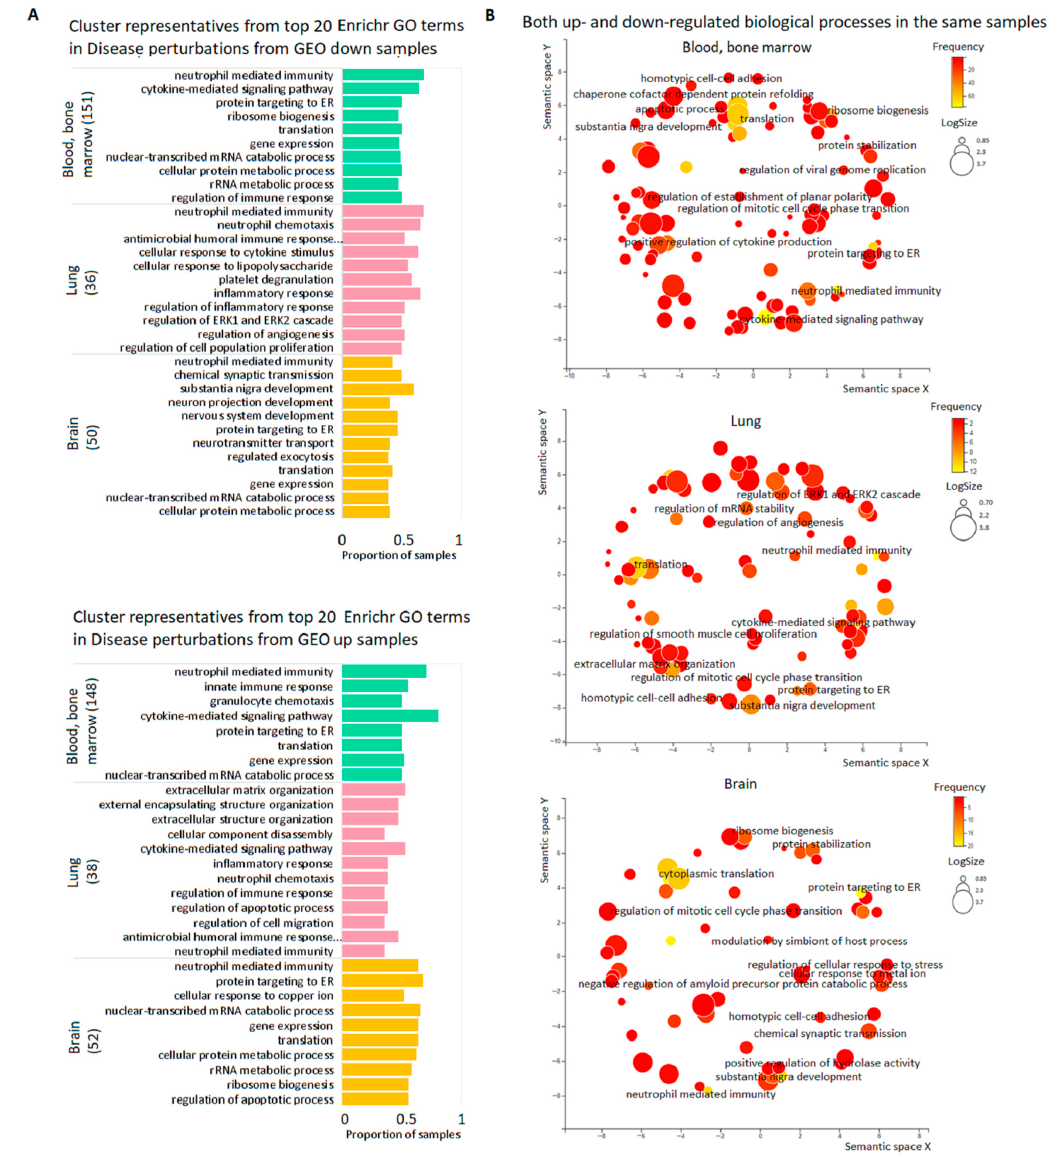
Figure 4. Top biological processes dysregulated in the pools of tissue samples. ( A ) Cluster repre- sentatives for the most frequent BP dysregulated in blood/bone marrow, lung, and brain. Cluster representatives for GO terms (terms remaining after reducing redundancy) were obtained using the REVIGO tool. The number of samples for each tissue is indicated in brackets. ( B ) REVIGO scatterplots for the same BP down-and up-regulated in the same samples. GO terms are plotted according to log size on the x -axis and frequency of occurrence (yellow is larger, red is smaller) in the samples on the y -axis. The size of the circles is proportional to the underlying frequency of the GO term in a reference database—the EBI GOA database. Functionally similar GO terms are located close to each other.